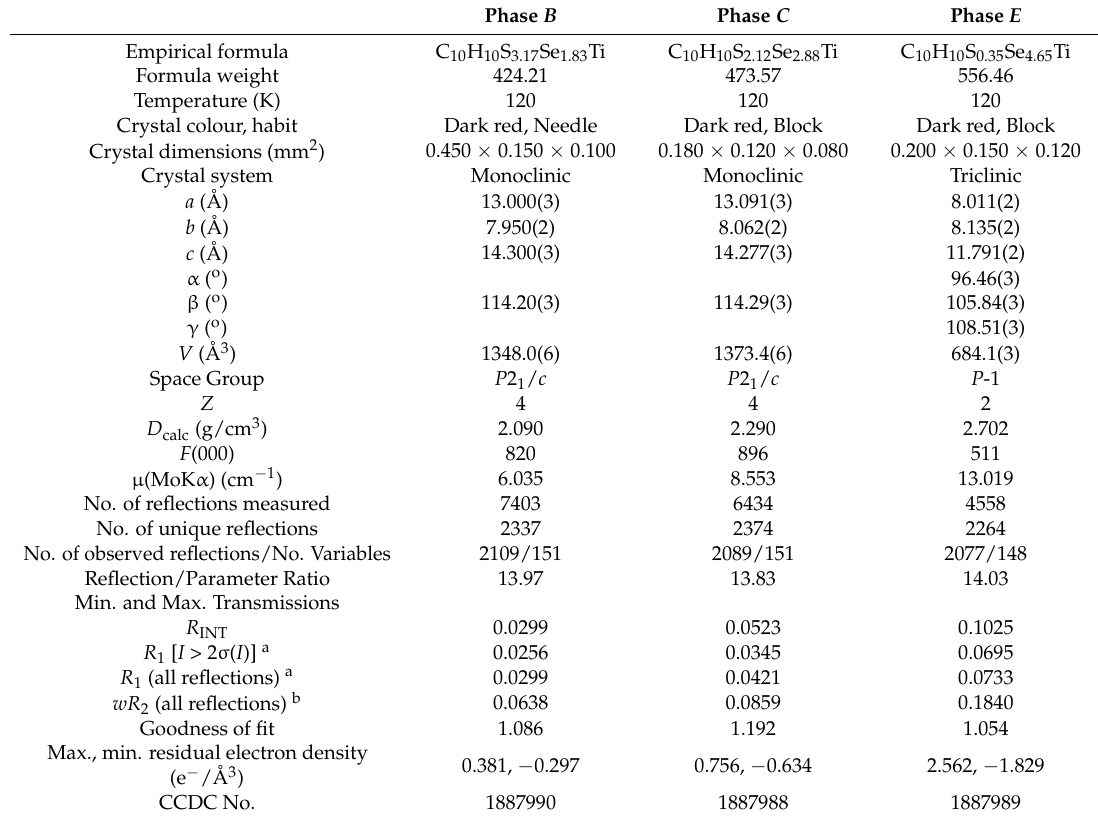
Table 4. Crystal data and details of structure determination of crystals from phases B (initial Se:S ratio 1:4) C (initial Se:S ratio 2:3), and E (initial Se:S ratio